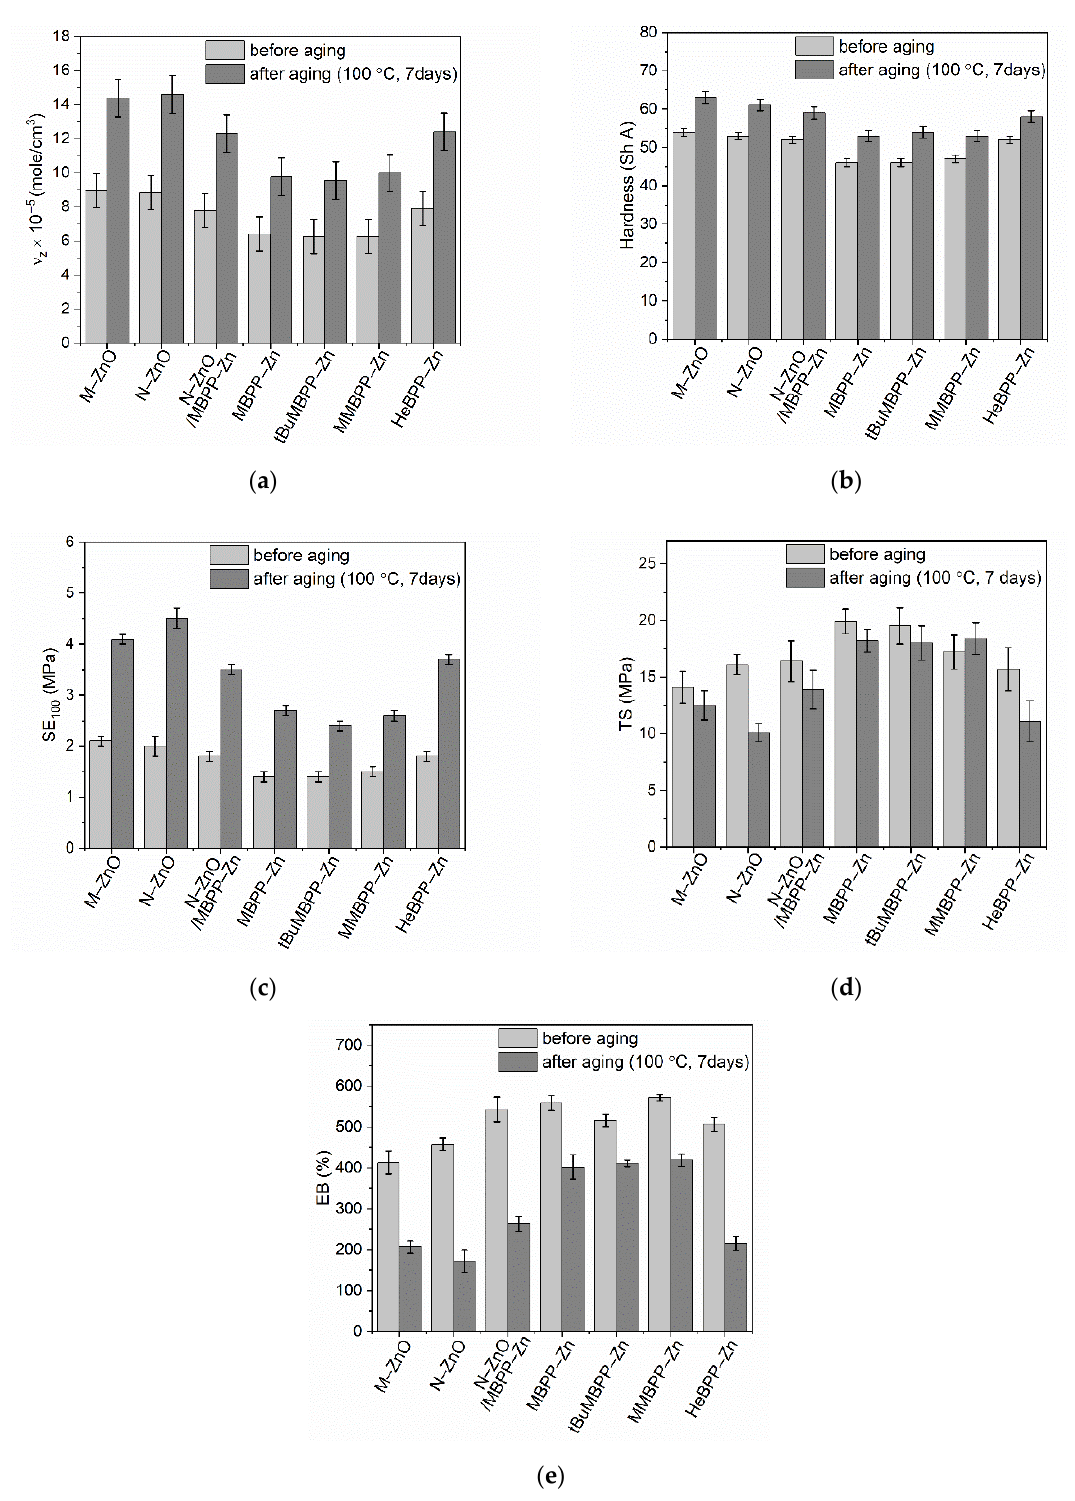
Figure 12. The influence of prolonged thermo-oxidation on the properties and crosslink density of SBR vulcanizates containing ZnO and zinc complexes with 1,3-diketones as activators: ( a ) crosslink density; ( b ) hardness; ( c ) stress at 100% relative elongation; ( d ) tensile strength; ( e ) elongation at break.